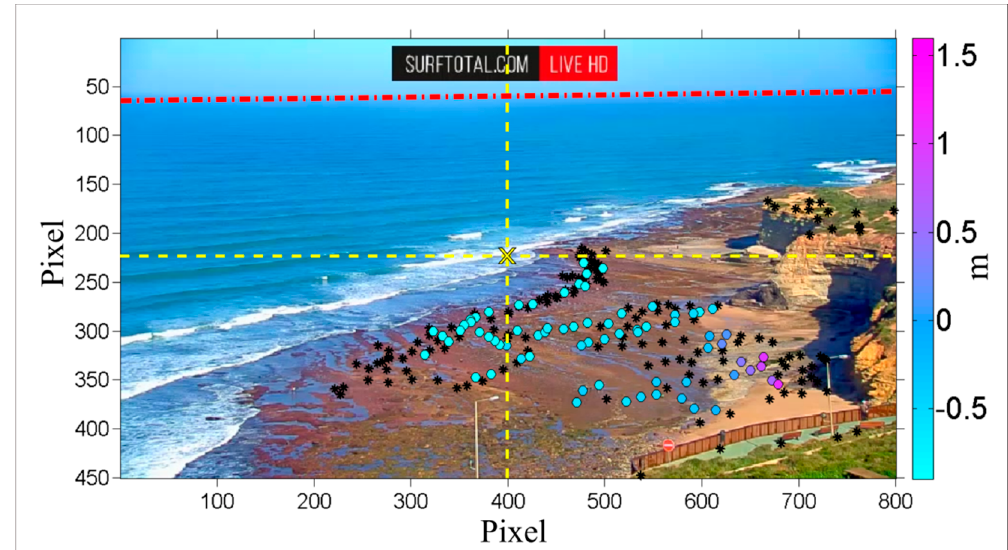
Figure 7. C-Pro operational procedure. Selected GCPs (colored dots according to their altitude value) and checkpoints (black stars) are plotted on surfcam frame acquired during low tide. The yellow dashed lines intersection indicates the principal point as the center of the image ( u c , v c = 400, 225). The red dashed line shows the horizon constraint detected by C-Pro.